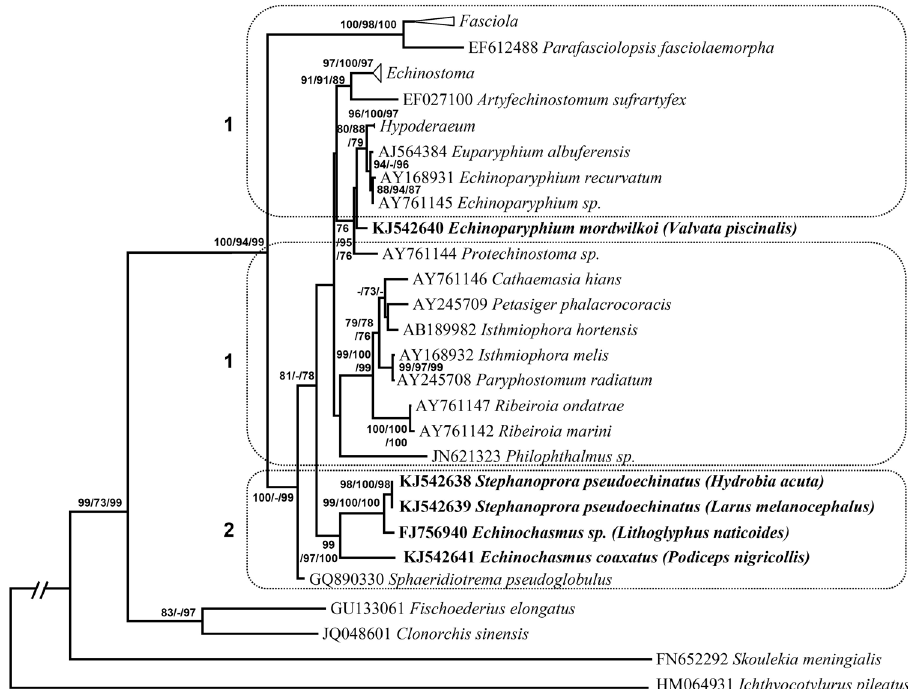
Figure 2. Phylogenetic ITS2 tree. Maximum likelihood phylogenetic tree based on analysis of riboso- mal DNA sequences (5.8S-ITS2-28S). Bootstrap percentages refer to maximum likelihood / neighbor- joing / maximum parsimony analysis. Only bootstrap values above 70% are shown. GenBank accession numbers are indicated before species names. Names of the target species are in bold; their hosts are pre- sented in parentheses. Compressed clades: Fasciola (comprised sequences under GenBank accession num- bers AM900370, EF534995, EF612486, JF496715), Echinostoma (AF067850, AF067852, AJ564383, AY168930, EPU58100, ETU58097, ELU58099, GQ463131, GQ463132), Hypoderaeum (AJ564385, GQ463134). Dotted rectangles 1 indicate digeneans whose life cycles include Lymnaeoidea as first inter- mediate host; dotted rectangle 2 indicates digeneans whose life cycles include prosobranch snails as first intermediate